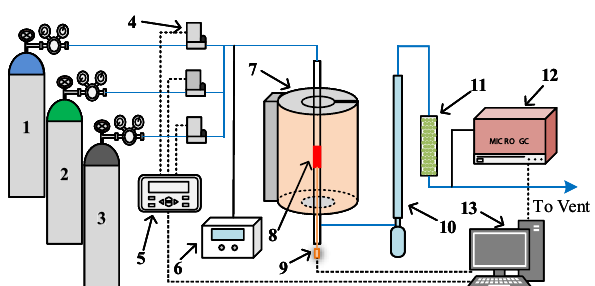
Fig. 1 Schematic diagram of fixed bed coal pyrolysis system. 1—H 2 cylinder; 2—CO cylinder; 3—N 2 cylinder; 4—mass flow controller, Parker 201, 0–100 mL/min; 5—mass flow controller box; 6—HPLC pump; 7—vertical tubular furnace, Carbolite VST 12/300; 8—quartz reactor, inner diameter of 1.2 cm, length of 55 cm; 9—thermocouple and temperature recorder; 10—condenser/coal tar trap system with CHCl 3 ; 11—moisture trap with dried CaSO 4 inside; 12—gas chromatograph, Inficon micro GC